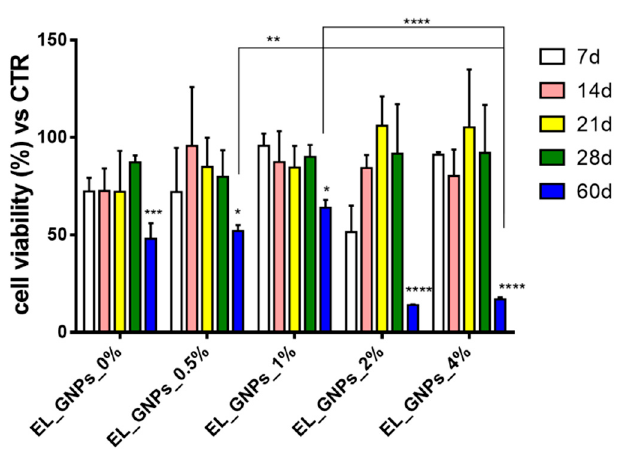
Figure 7. Cytotoxicity evaluation of incubation medium from in vitro degradation test, withdrawn at 7, 14, 21, 28 and 60 d of incubation. Results expressed as cell viability percentage, mean ± SD ( n = 3). Positive CTR was untreated cells (100% cell viability). Tukey’s multiple comparisons test reveals statistic differences for (*) p value < 0.05, (**) < 0.01, (***) < 0.001, (****) < 0.0001.